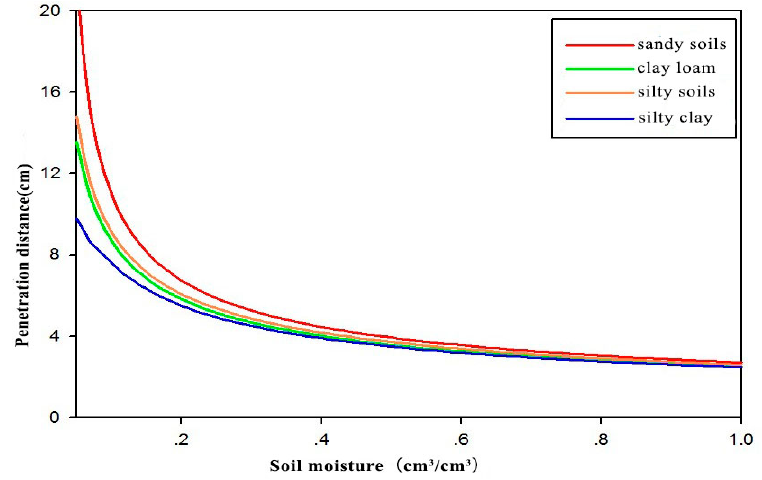
Figure 8. Dependence of the penetration distance of the GPS L1 band signal on soil moisture for different soil types.